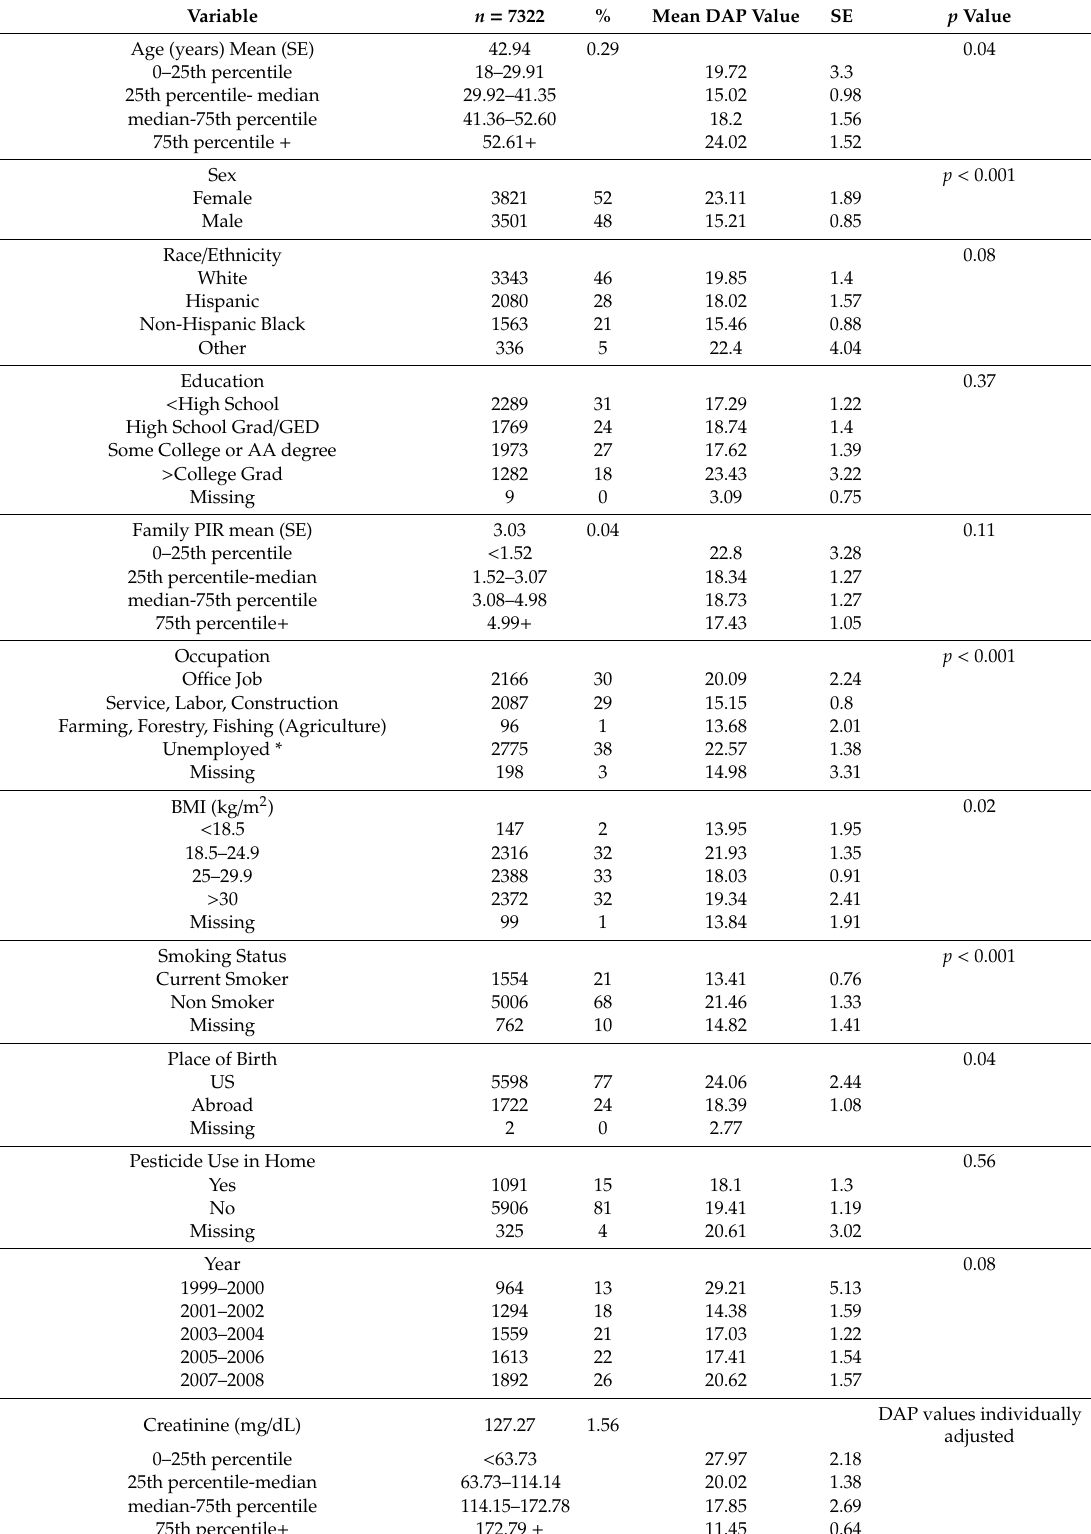
Table 1. Statistics and univariate values for adults sampled in the NHANES study between 1999 and 2008. Variable n = 7322 % Mean DAP Value SE p Value Age (years) Mean